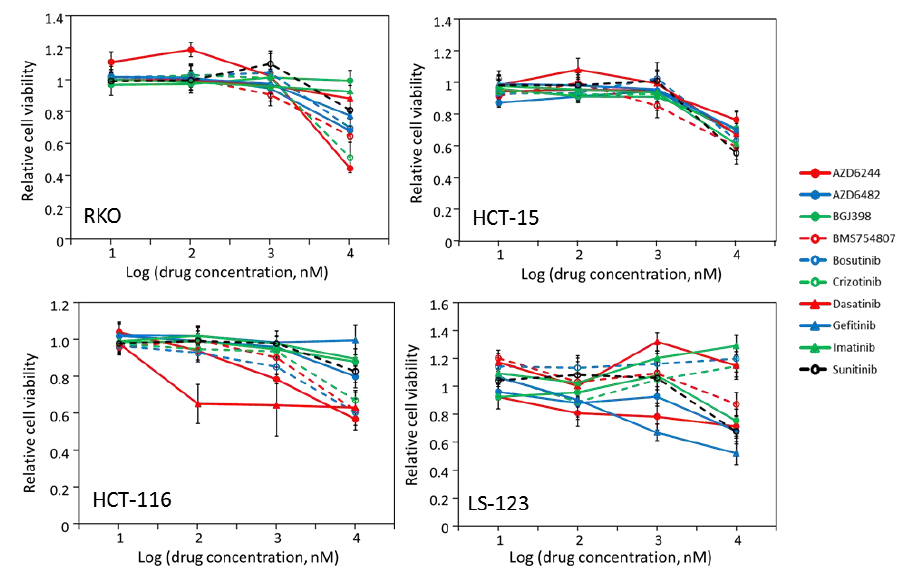
Figure 1. Drug sensitivity of colorectal cancer cells, RKO, HCT-15, HCT-116 and LS-123. Cell viability was determined after the cells were incubated with the drugs at indicated concentrations for 72 h using the MTT assay as described in Materials and Methods. Presented are based on two independent assays containing triplicates. The cell lines are labeled in the graphs. Cell viability incubated in the absence of the inhibitors is taken as 1, and standard deviations are presented as error bars.